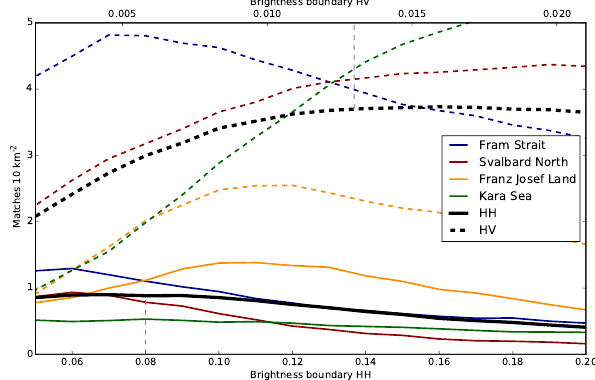
Figure 3. Upper brightness boundary σ 0 max (Eq. 2) vs. number of matches of the four test image pairs from Table 1. Solid and dashed lines represent results for HH and HV respectively. Black lines are the mean values of the four image pairs. Vertical grey lines at 0.08 (HH) and 0.013 (HV) represent chosen parameters.